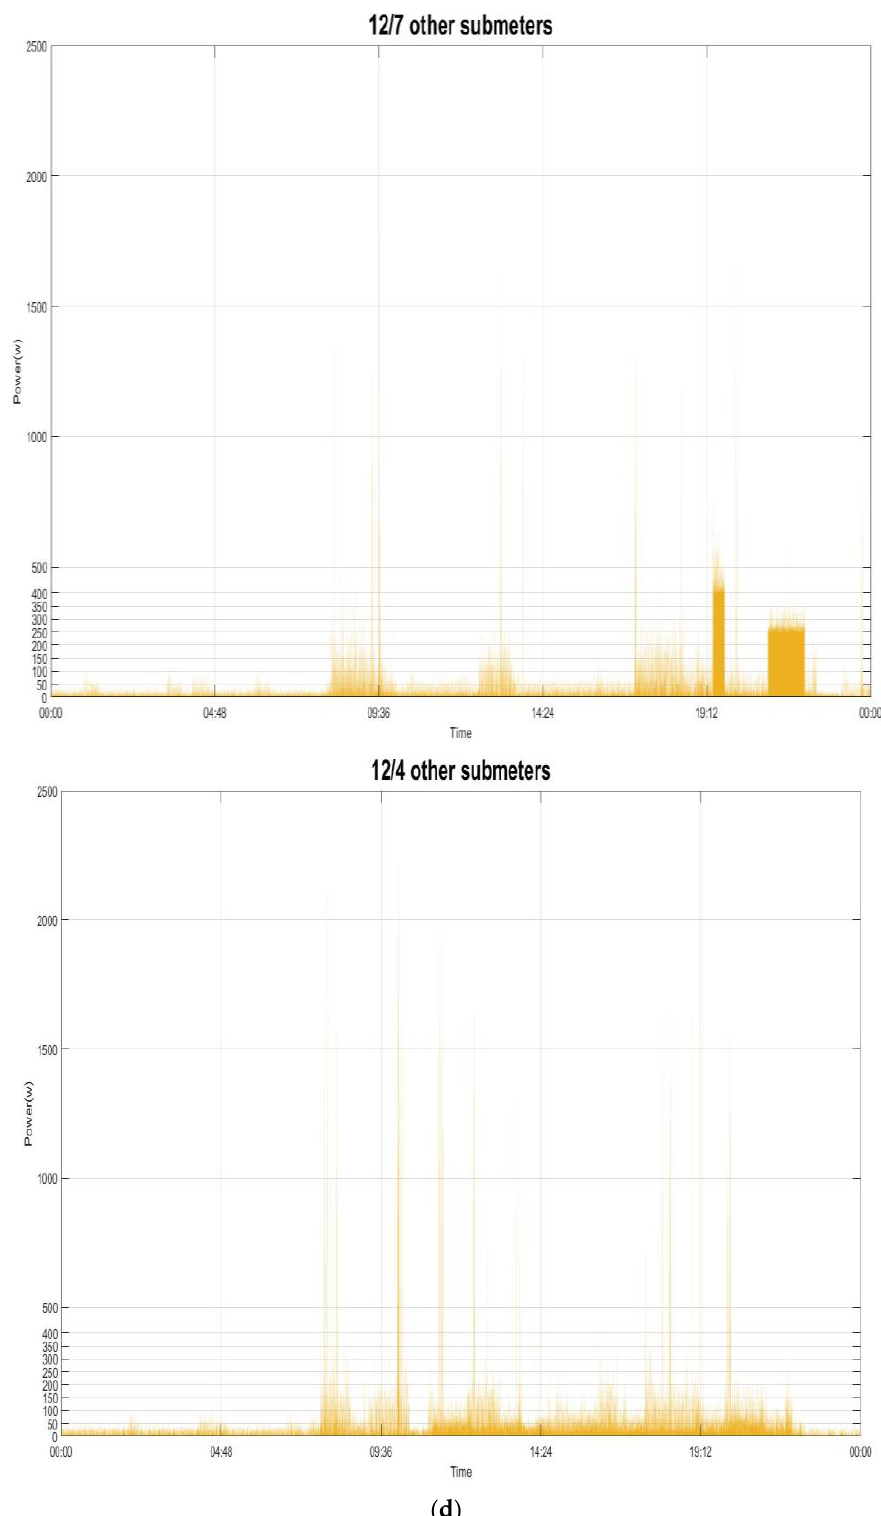
Figure 7. Shown power demand of most of the electrical appliances: ( a ) fridge; ( b ) htpc; ( c ) washer dryer; ( d ) other submeters.